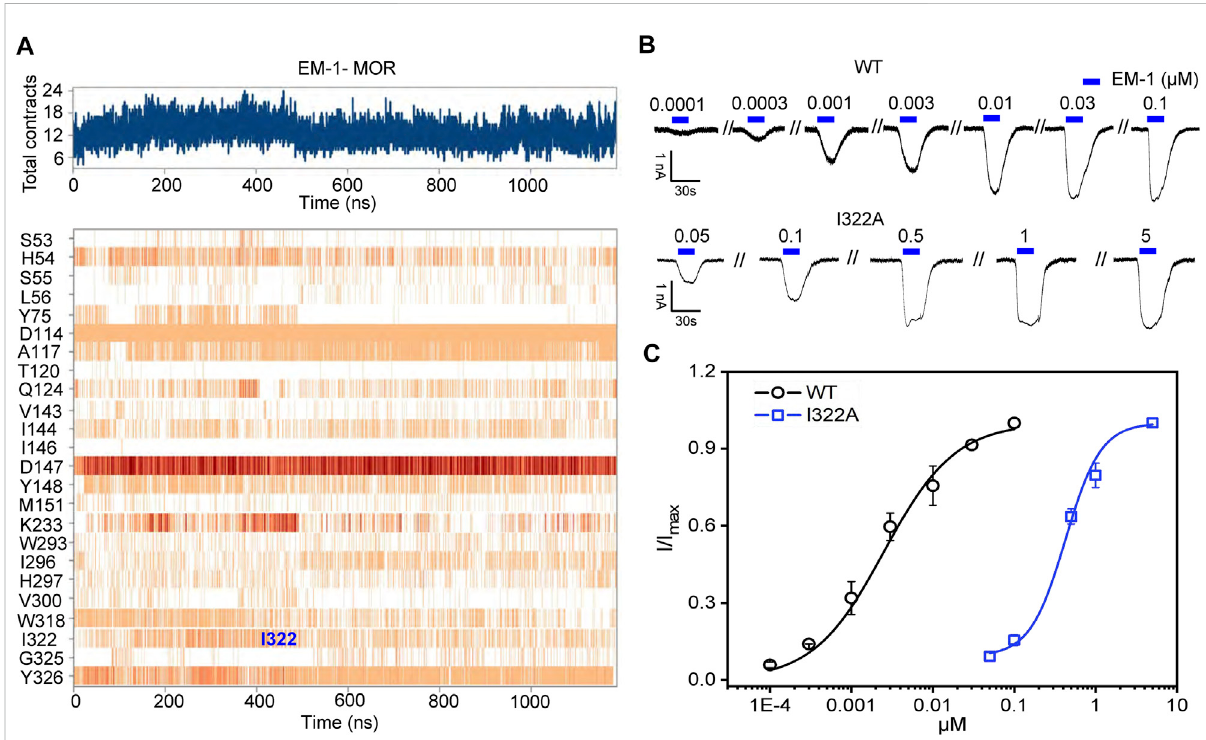
Mutation at site 322 disrupts EM-1 binding to MOR. (A) time-dependent interaction between residues of EM-1 and MOR binding pocket. B , C , representative current traces (B) and concentration-response relationships (C) for EM-1 in cells with co-expression of hGIRK4 S143T channels and